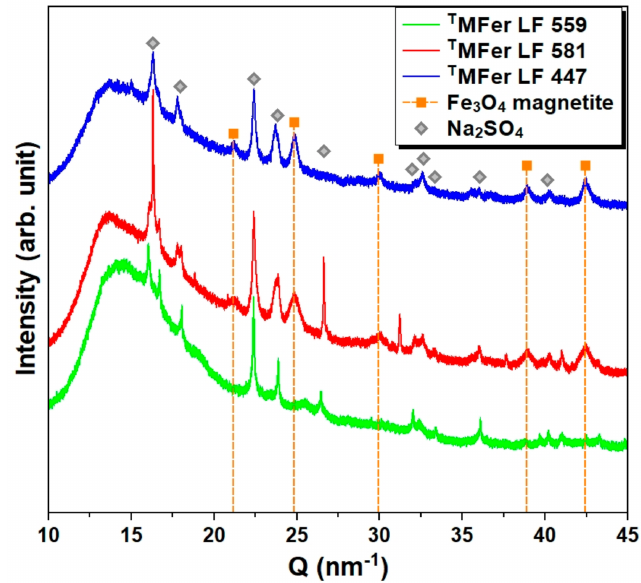
Figure 5. X-ray diffraction patterns for powdered magnetoferritin. T MFer with LF 559, 581, and 447 was prepared at various synthesis temperatures (37, 65, and 75 ◦ C). Marked peaks corresponded to magnetite and Na 2 SO 4 as major crystalline phases. T prefix in T MFer labeling was used for specification of magnetoferritin samples prepared at three different synthesis temperatures with similar loading factor